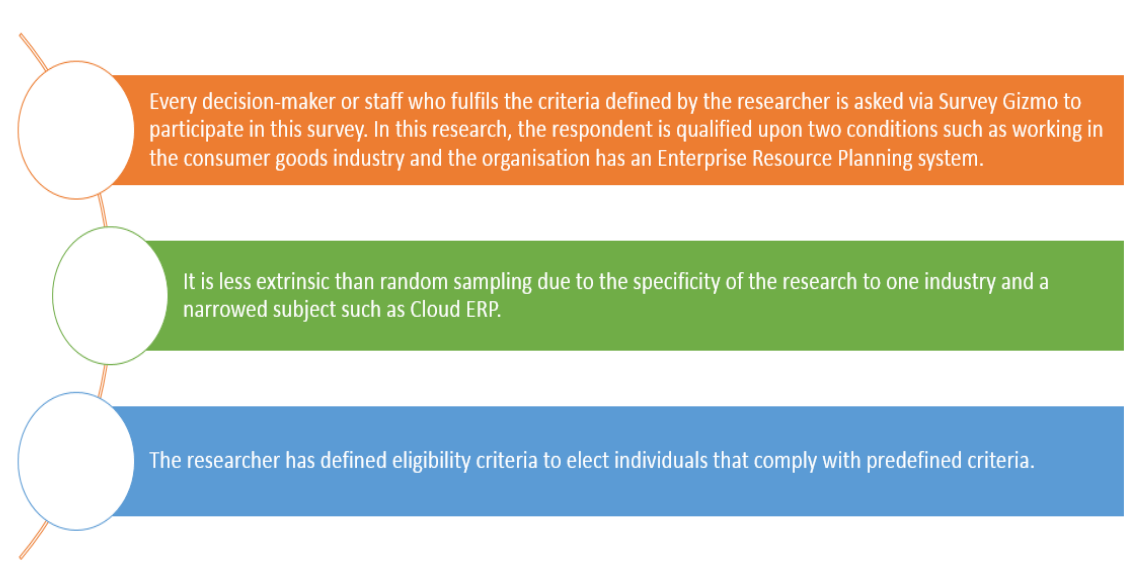
Figure 8. Research sampling. Table 5. Hypothesis design.